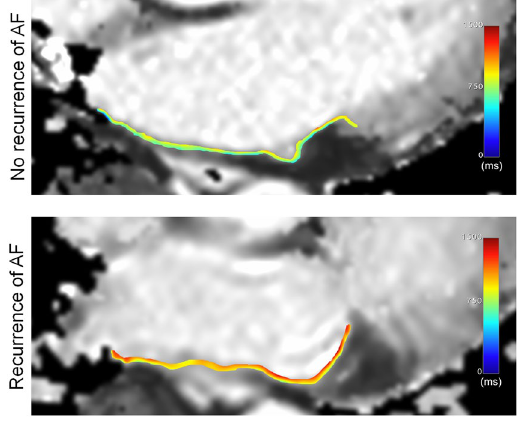
Figure 3. Example of T1 relaxation time measurements of the left atrial posterior wall. T1 relaxometry data was measured via region of interest (ROI) analysis. For better visualization, T1 relaxation times within the ROIs are color-coded. The patient with no recurrence of atrial fibrillation had a left atrial T1 relaxation time of 662 ms. The patient with recurrence had a left atrial T1 relaxation time of 915 ms. AF = atrial fibrillation.